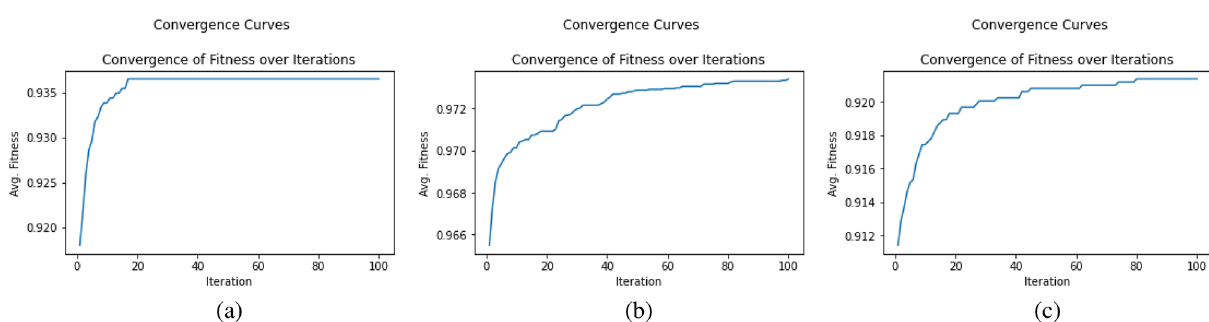
Figure 15. Graph showing the confusion matrices generated by our proposed HAR framework on: ( a ) HARTH, ( b ) KU-HAR and ( c ) HuGaDB datasets.